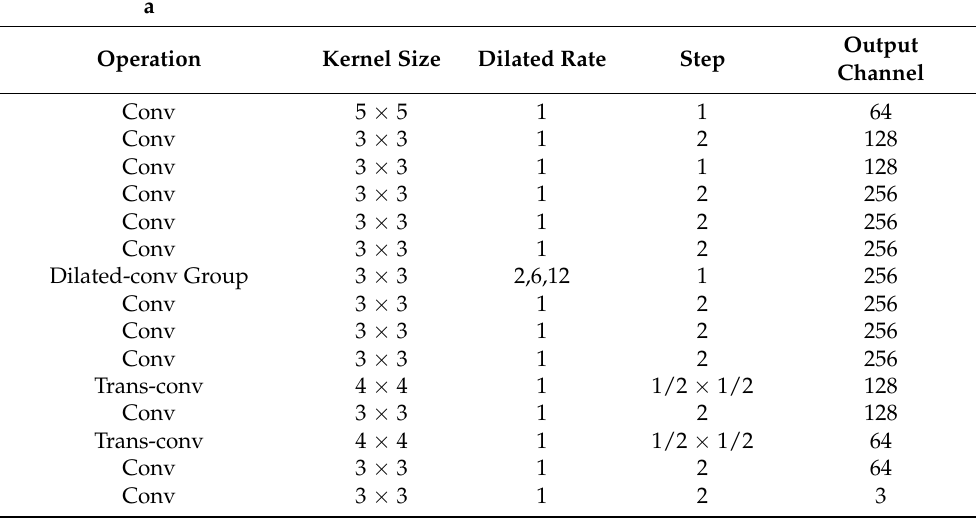
Table 1. a : MDTMN’s Generator Network Details. b: Overall\Partial Distress Discriminator Net- work Details. c: Features Concatenation Layer.